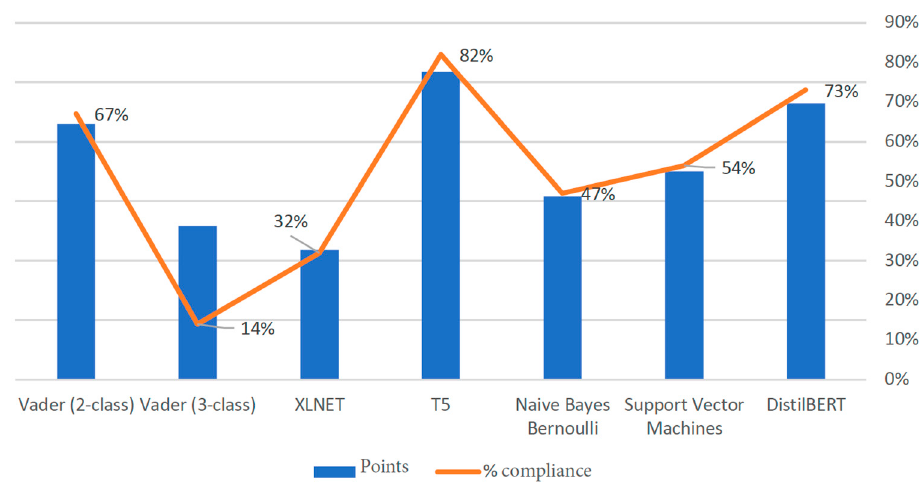
Figure 3. Test of sentiment research methods for Polish comments without those considered neu- tral.